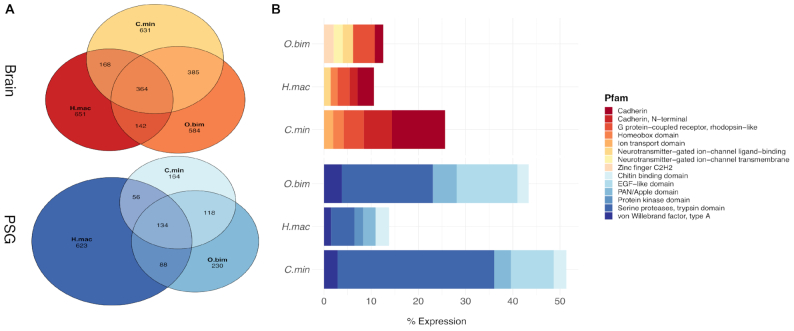
Dynamics of gene expression in neural and venom-producing tissues of octopods. Tissue-specific expression of genes within the brain (red) and posterior salivary gland (PSG) (blue) of H. maculosa (H.mac), O. bimaculoides (O.bim), and C. minor (C.min). A) Venn diagram shows numbers of shared and exclusive genes between species (left). B) Bar chart of the top 5 Pfams and their contribution to overall expression in the brain (right).